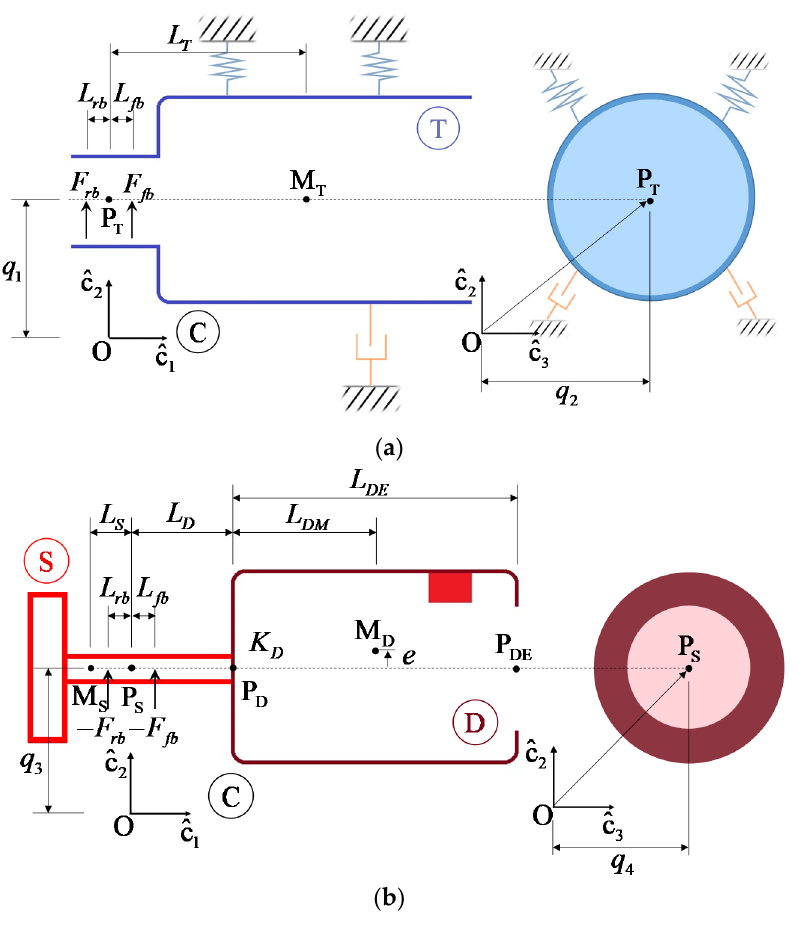
Machines 2021 , 9 , x FOR PEER REVIEW Figure 2. Side and front views of the assemblies: ( a ) tub assembly and ( b ) drum-shaft assembly. Figure 2. Side and front views of the assemblies: ( a ) tub assembly and ( b ) drum-shaft assembly. Figure 3 shows the body 2-3 rotations of the three rigid bodies. The coordinate sys- ˆt ( 1,2,3) i = , and ˆ d ( 1,2,3) i = , ˆs ( 1,2,3) i = are fixed to body T, body S, and body D, tems i i i respectively. Each body has 2 degrees of freedom for the rotational motion. The general- q i = represent the Euler angles of body 2-3 rotations of body ized coordinates ˆ ( 5, 6,7 , 8) i q i = represent the T and body S relative to the cabinet. Generalized coordinates ˆ ( 9,10) i θ Euler angles of body 2-3 rotation of body D relative to body S. A prescribed motion ( ) t ˆ s . Table 1 shows the direction cosine is given to body S in the direction of the shaft axis 1 tables among the four coordinate systems.